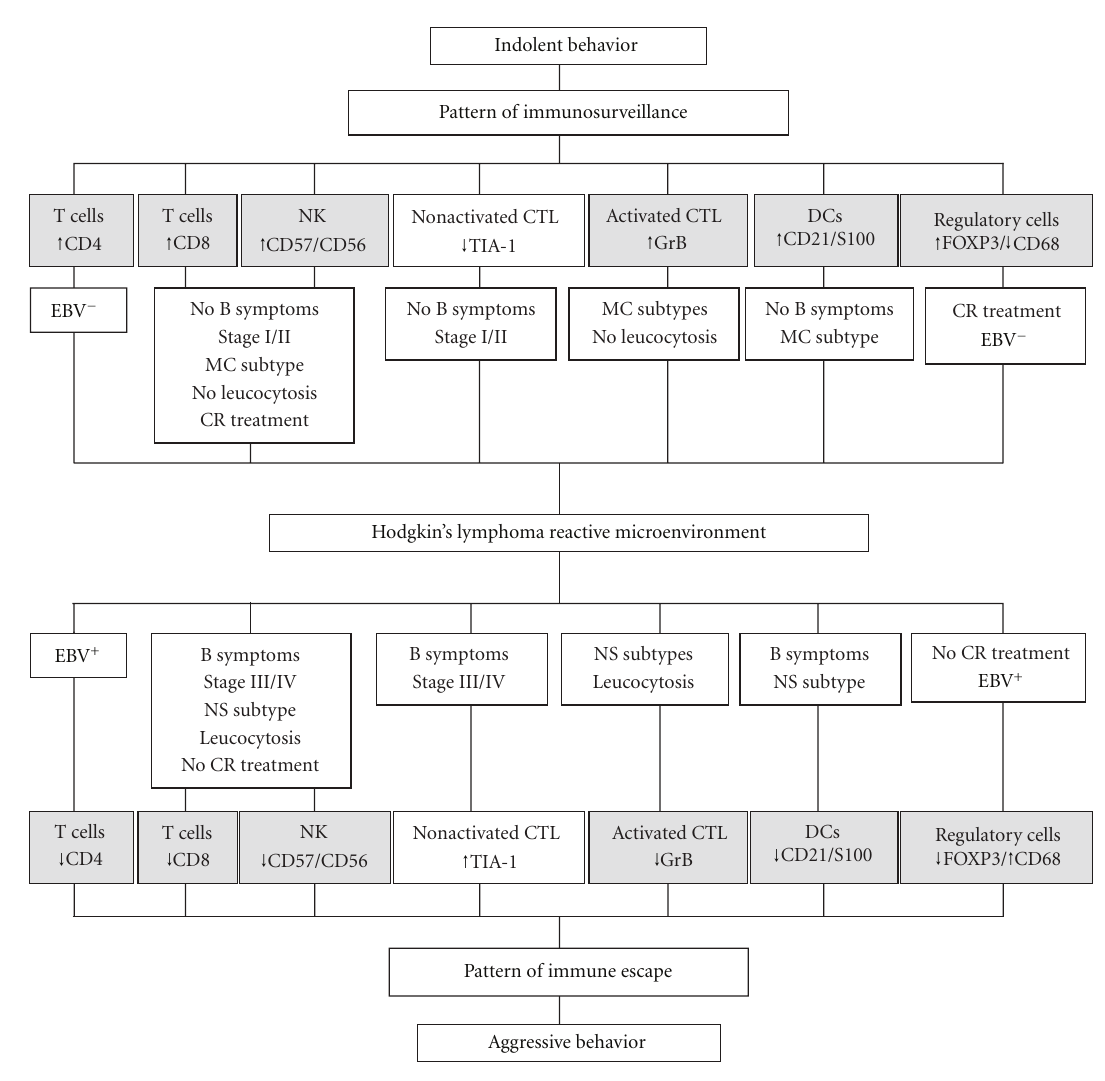
Figure 4: Representation of the two immune patterns observed in HL significantly associated with their clinicopathological features. The immunosurveillance pattern with a high proportion of infiltrating T lymphocytes, NK cells, DCs, activated CTL, but low proportion of resting CTL and TAM is associated with a favorable outcome. The immune escape pattern with a high proportion of infiltrating resting CTL and TAM, but low proportion of T lymphocytes, NK cells, DCs, and activated CTL is associated with an unfavorable outcome. MC, mixed cellularity; NS, nodular sclerosis; CR, complete